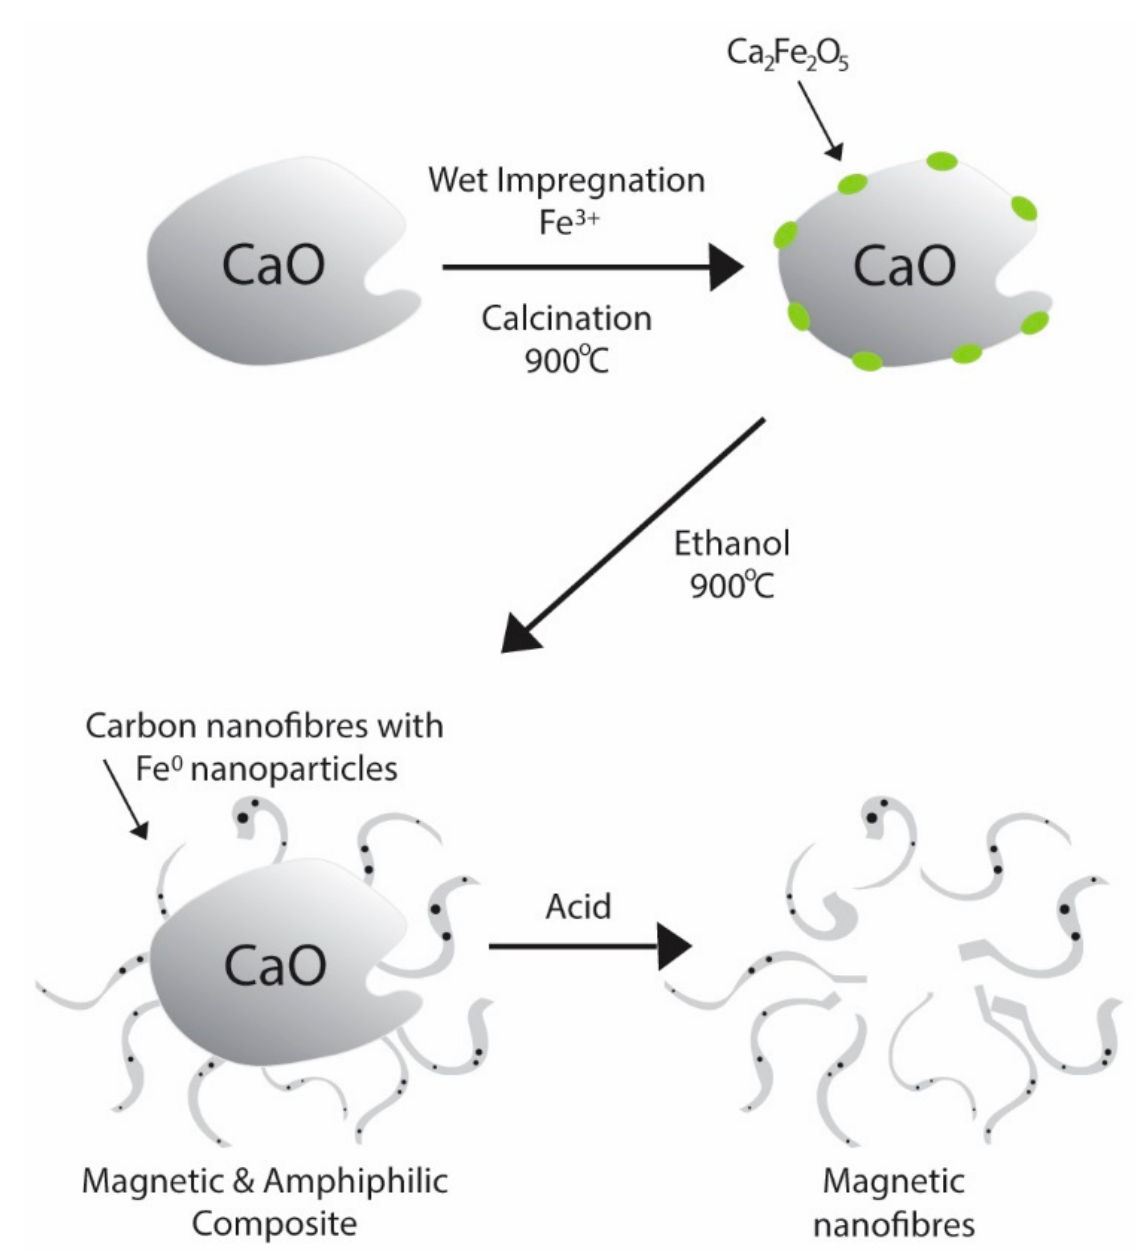
Figure 1. Schematics of production of mixed calcium iron oxide, carbon nanofibers supported in CaO and pure magnetic nanofibers.